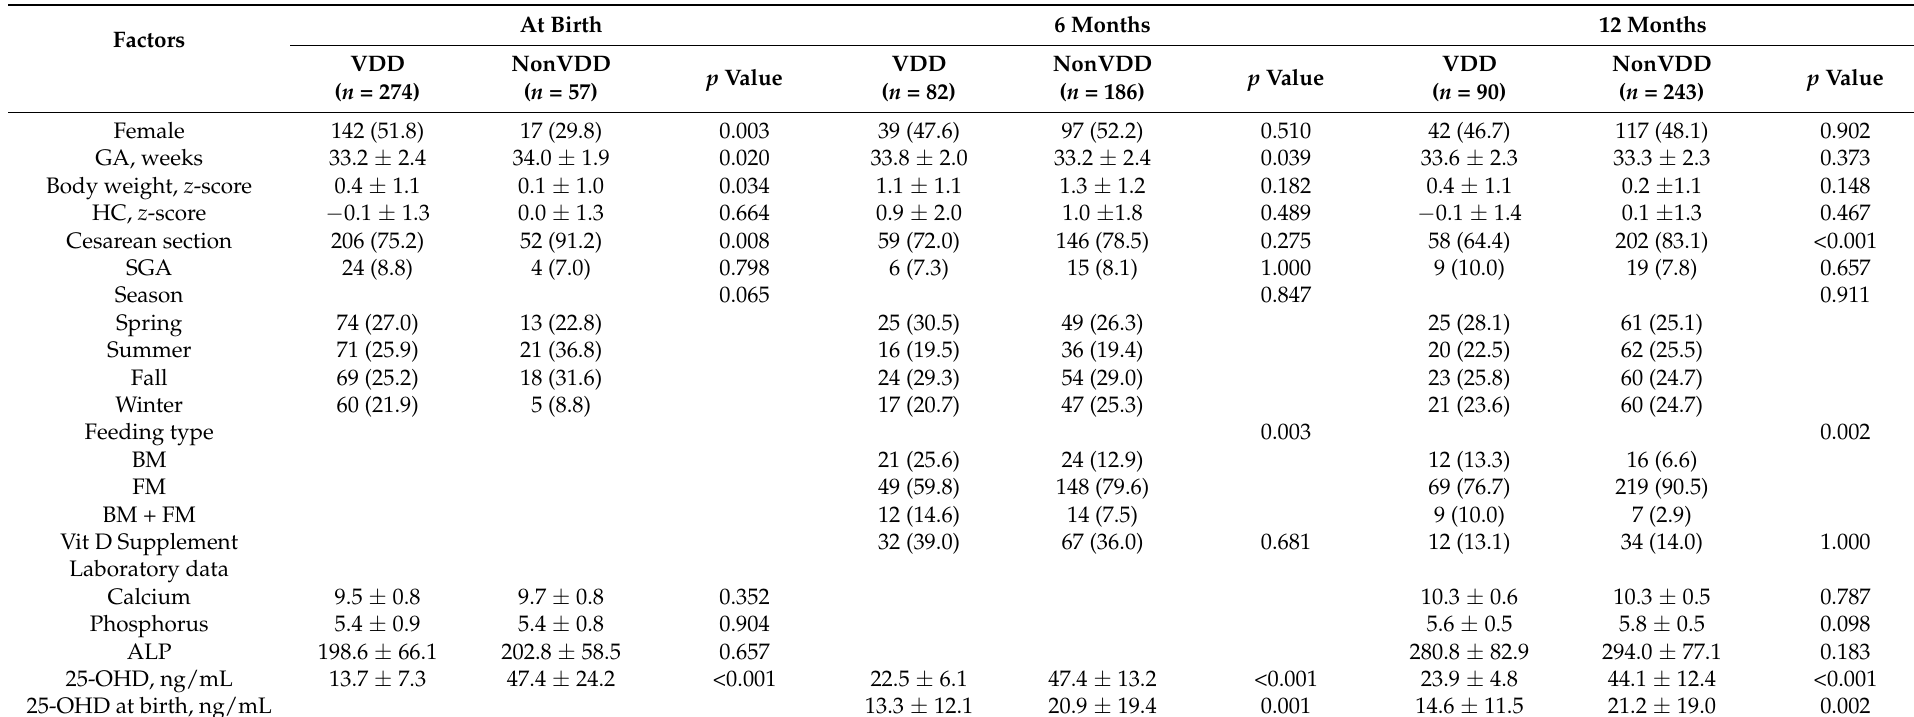
Table 2. Comparison of neonatal clinical and demographic factors between infants with and without vitamin D